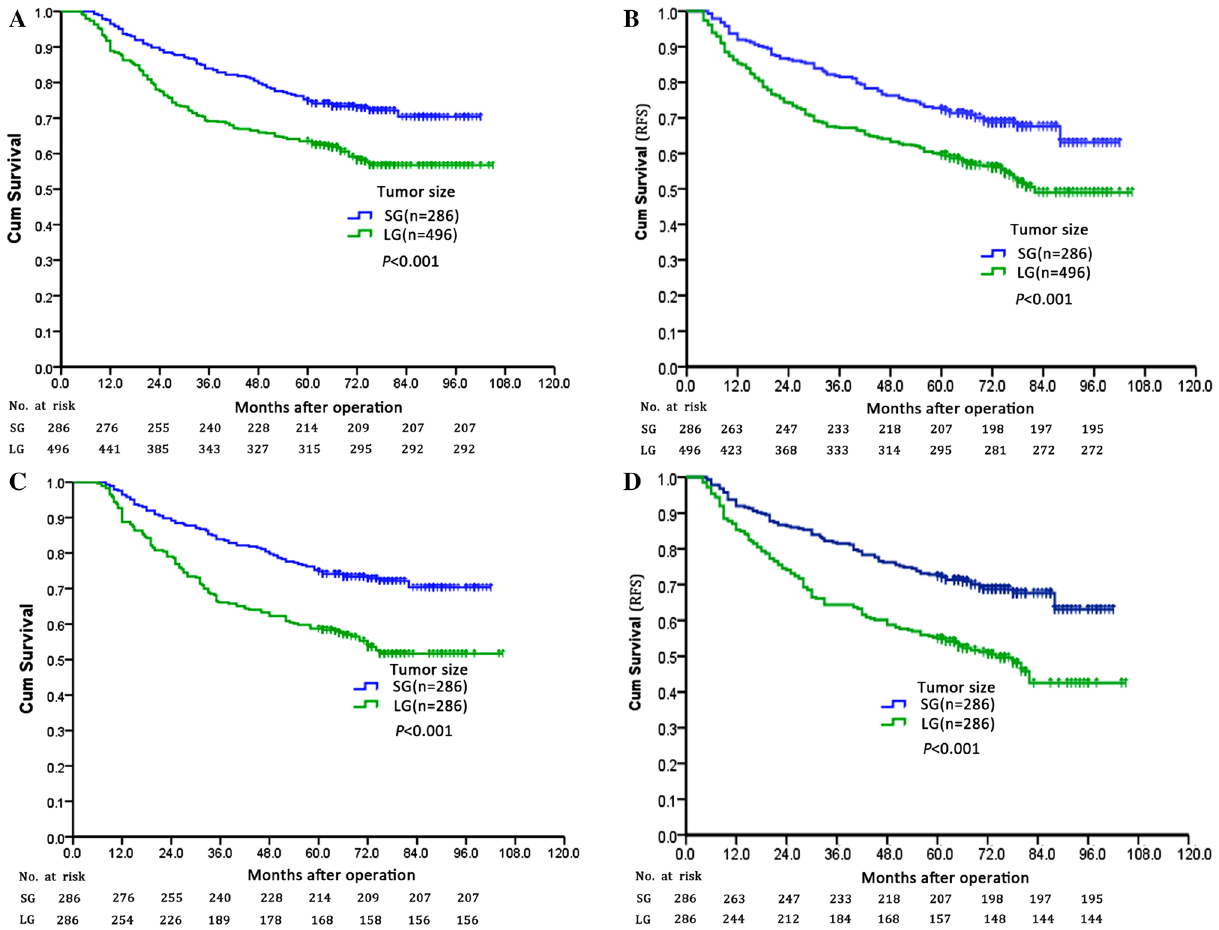
Figure 2. Prognosis of CC patients who underwent curative surgery. Patients were categorized into two groups according to the tumor size: SG and LG. ( A ) Overall survival curve for all patients: the 5-year OS rates were 75.2% and 63.5% for SG and LG, respectively ( P < 0.001). ( B ) Relapse-free survival for all patients: the 5-year RFS rates were 72.4% and 59.5% for SG and LG, respectively ( P < 0.001). ( C ) Overall survival curve for matched patients: the 5-year OS rates were 75.2% and 58.7% for SG and LG, respectively ( P < 0.001). ( D ) Relapse- free survival for matched patients: the 5-year RFS rates were 72.4% and 54.9% for SG and LG, respectively ( P <